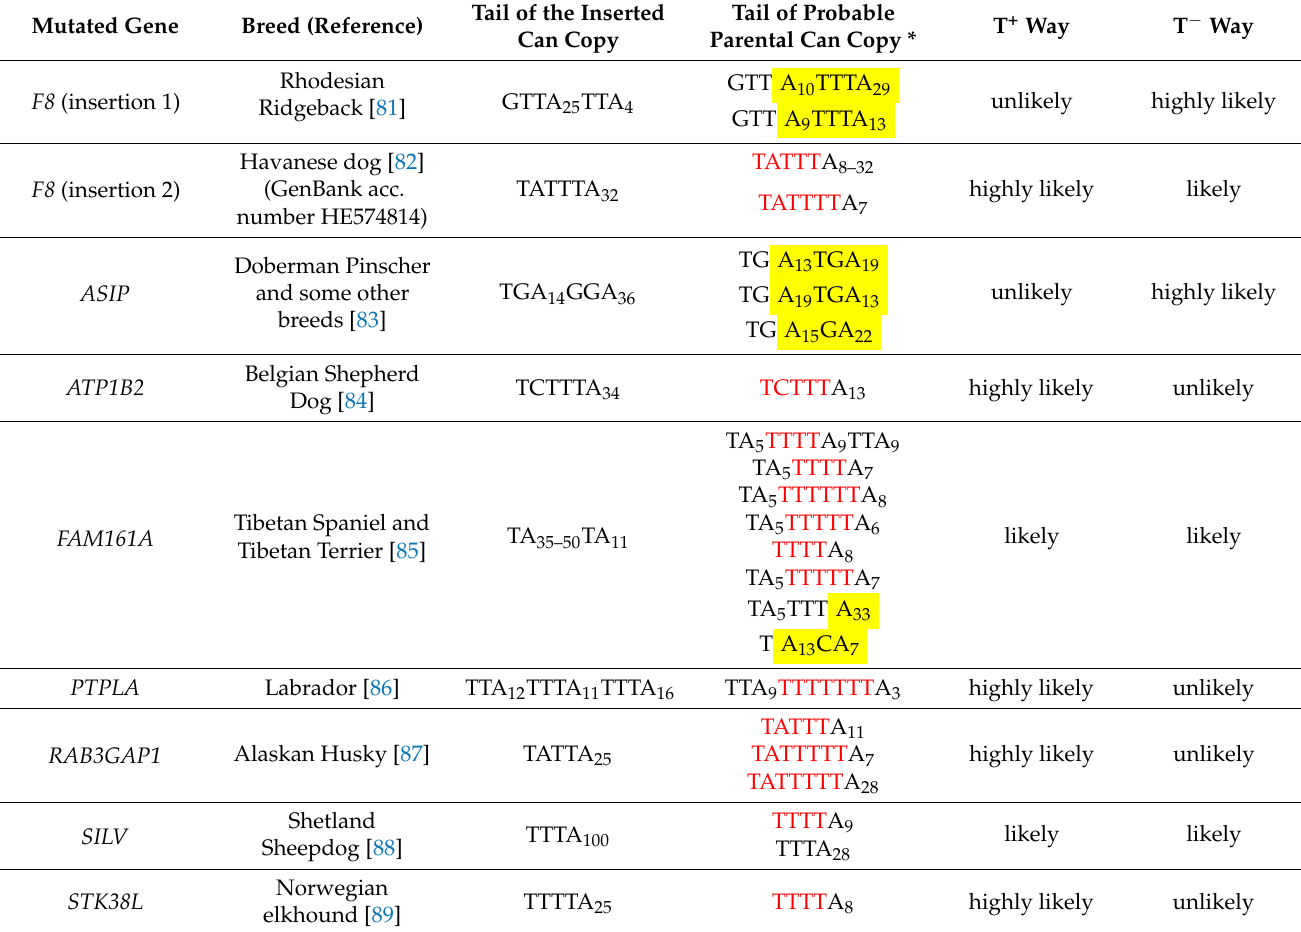
Table 3. Can_b2 insertions that caused gene mutations and putative retrotransposition